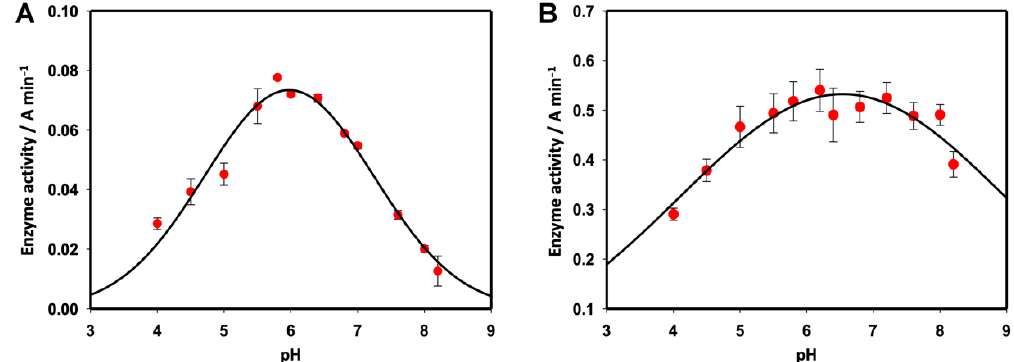
Figure 3. Effect of pH on ( A ) Slt35 and ( B ) lysozyme activity. For Slt35, 7 μ M enzyme and 0.6 mg mL − 1 cell suspension were used at 37 °C in 25 mM Tris-maleate containing 10 mM CaCl 2 . For the lysozyme, 0.1 μ M enzyme and 0.6 mg mL − 1 cell suspension were used at 37 °C in 25 mM Tris-maleate containing 100 mM KCl.